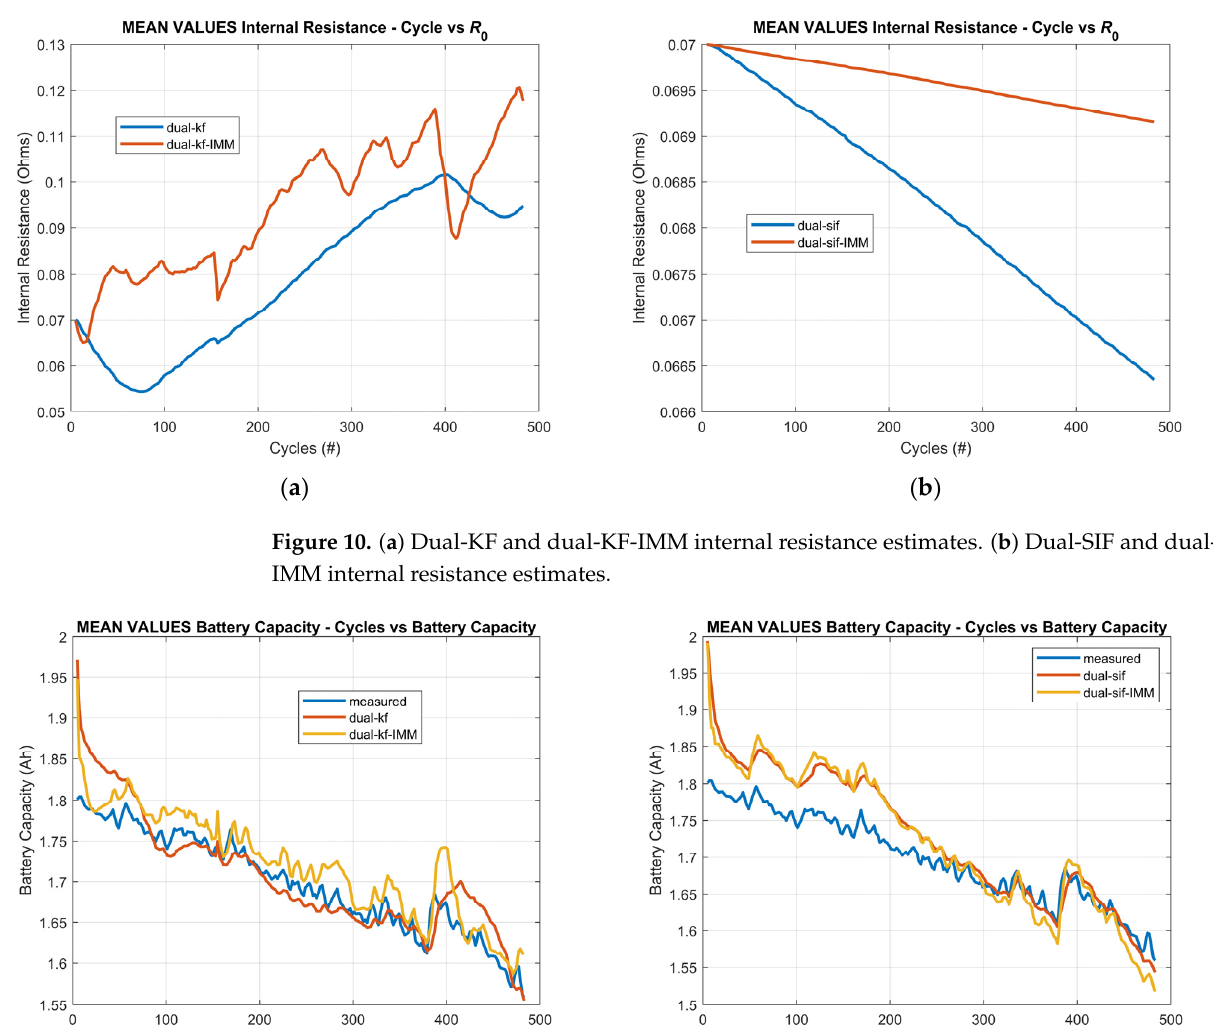
( b ) Figure 11. ( a ) Dual-KF and dual-KF-IMM battery capacity estimates. ( b ) Dual-SIF and dual-SIF- IMM battery capacity estimates. Figure 12 depicts all the battery capacity estimation results from all algorithms across all cycles in one plot for better visualization.